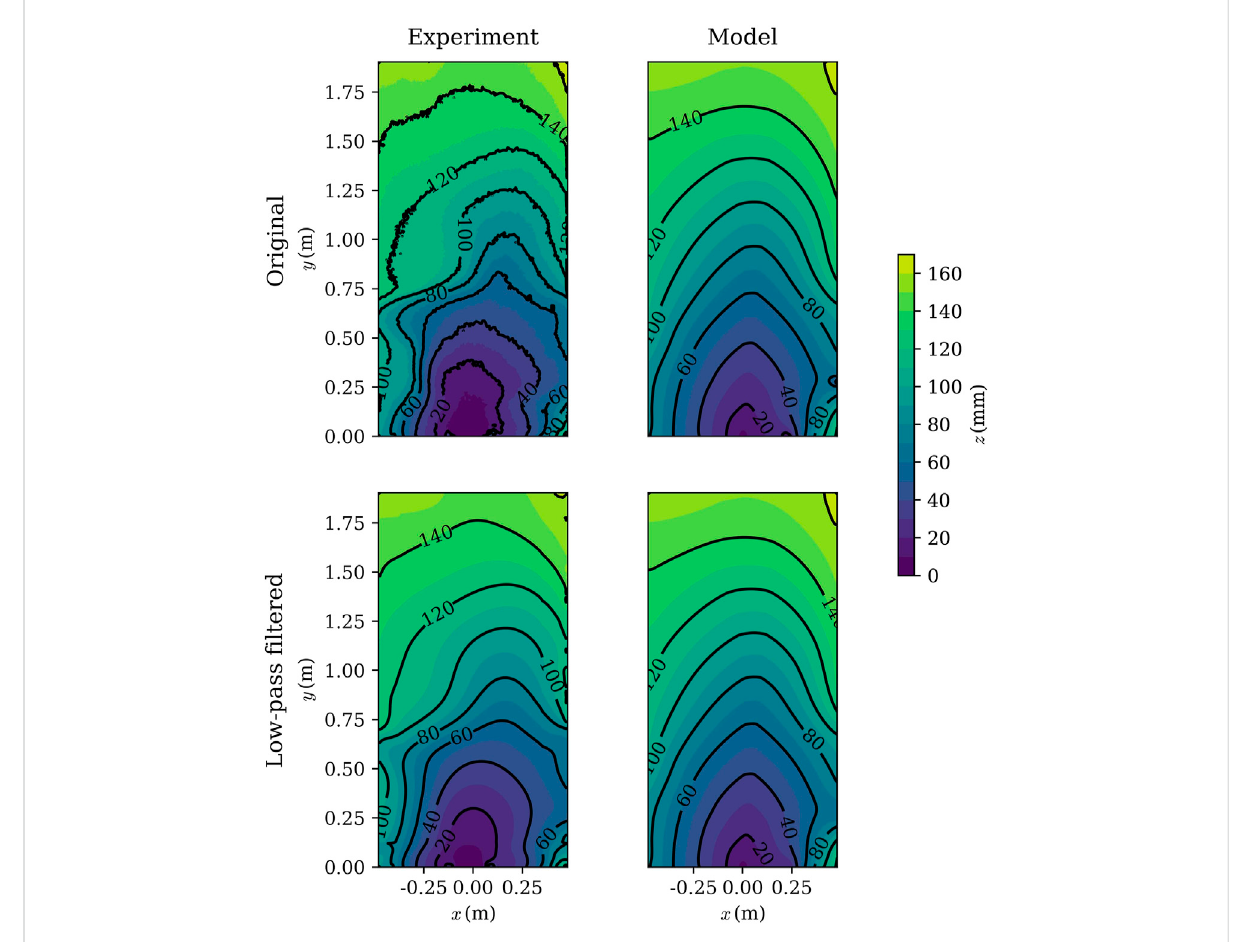
FIGURE 7 The original morphology of and the low-pass fi ltered morphology at t = 8